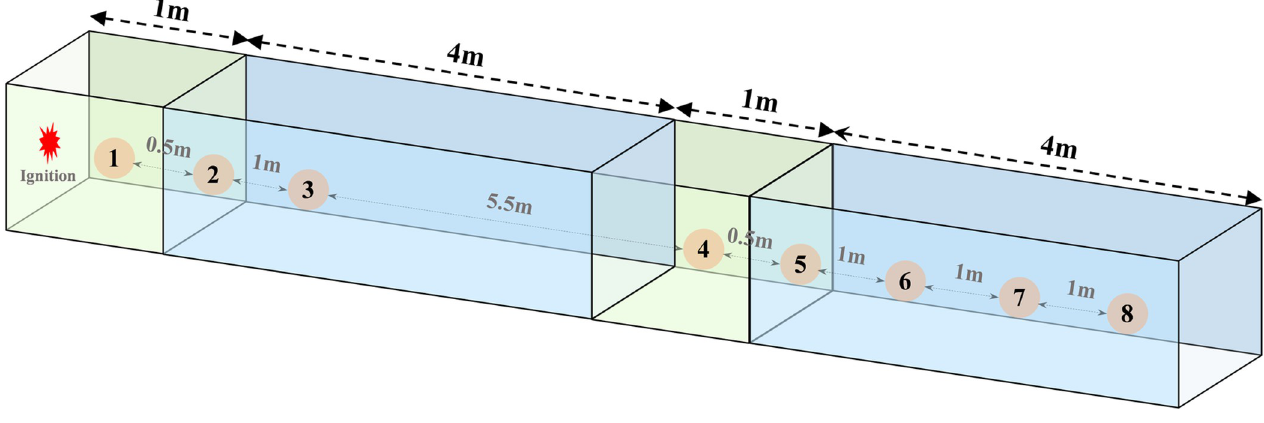
Fig 10. Explosion model in the tube.